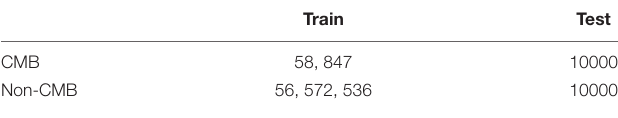
TABLE 1 | Dividing of the dataset for training and